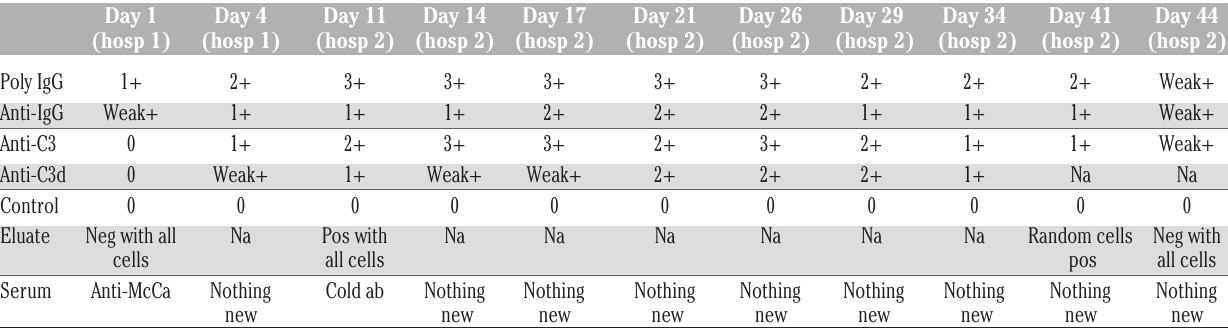
neg, negative; pos, positive; na, test not performed; hosp, hospitalization.